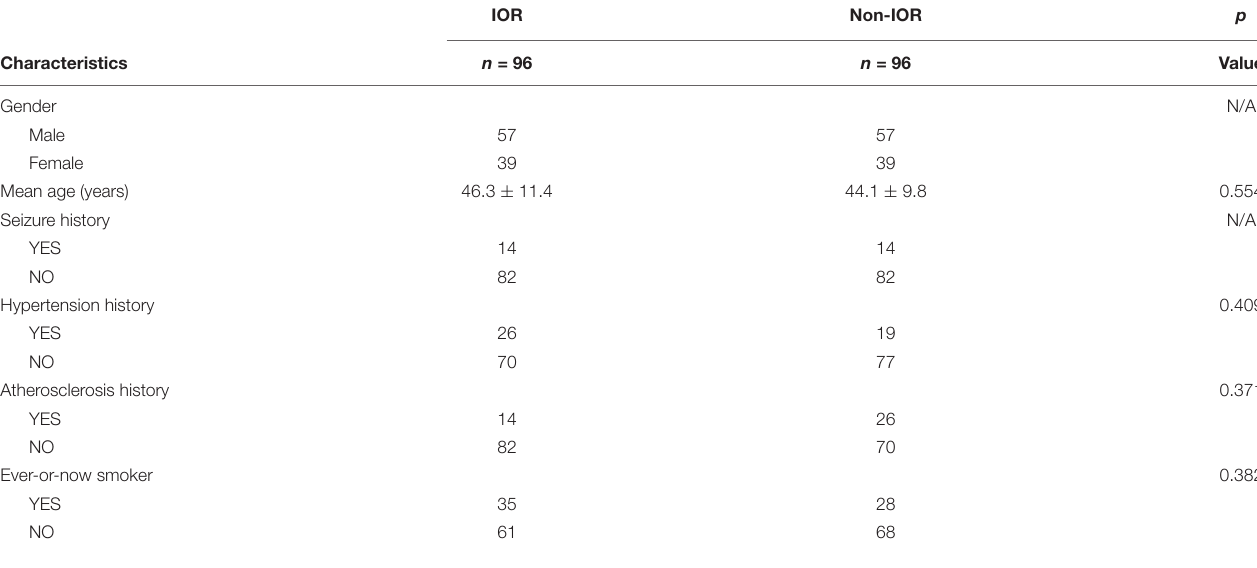
TABLE 1 | Demography information of enrolled